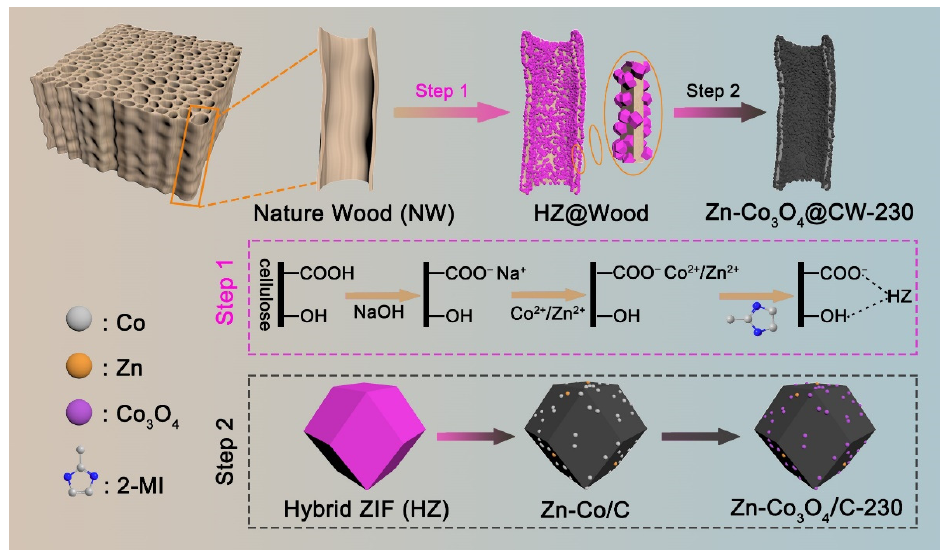
Figure 1. Schematic representation of the fabrication procedure for Zn-Co 3 O 4 @CW-230.